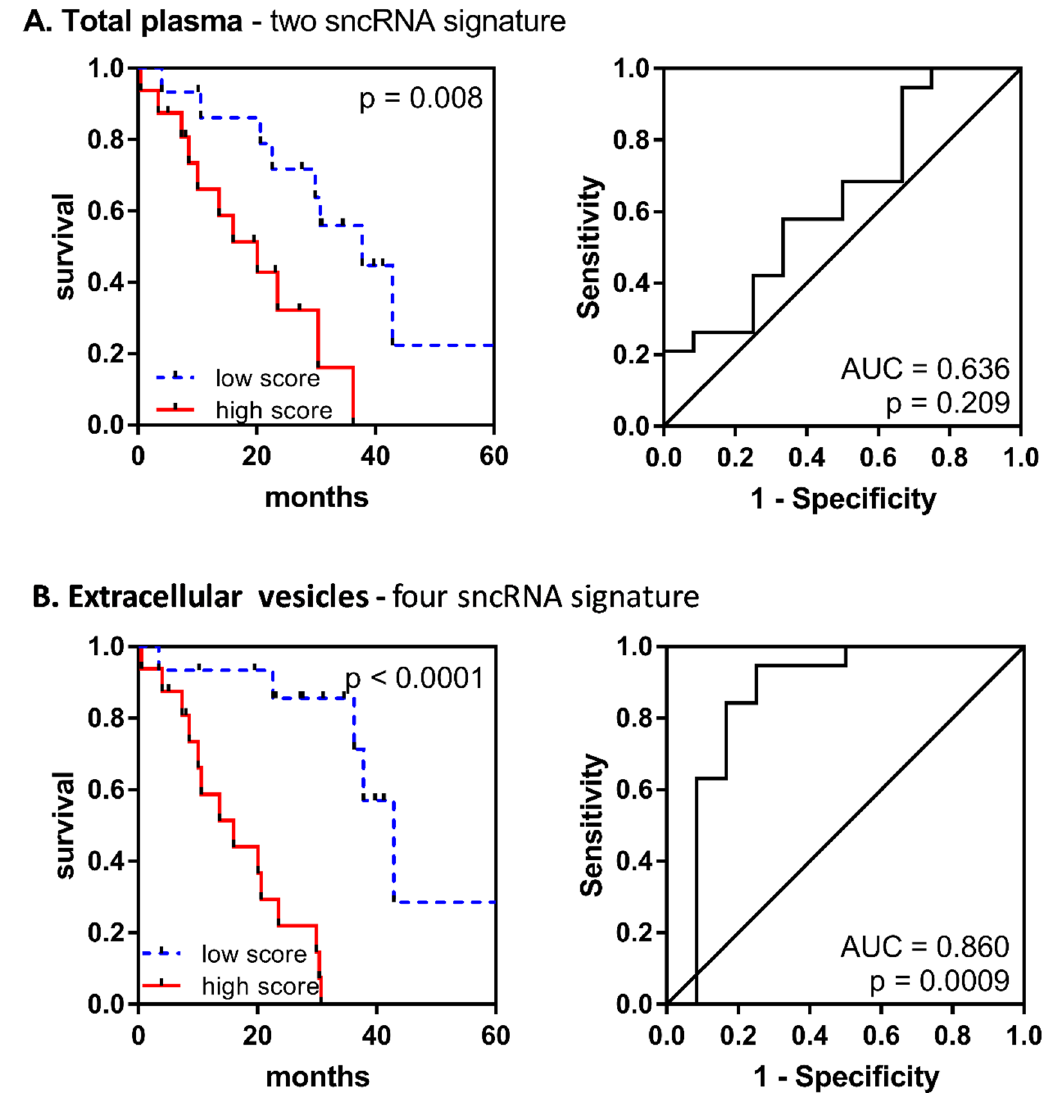
Figure 4. Performance of the combined prognostic model for the overall survival of MDS patients. Kaplan–Meier curves and receiver operation characteristic (ROC) curves are shown for ( A ) a two-sncRNA signature (miR-1260b and miR-328-3p) in total plasma and ( B ) a four-sncRNA signature (miR-1237-3p, U33, hsa_piR_019420, and miR-548av-5p) in EVs.